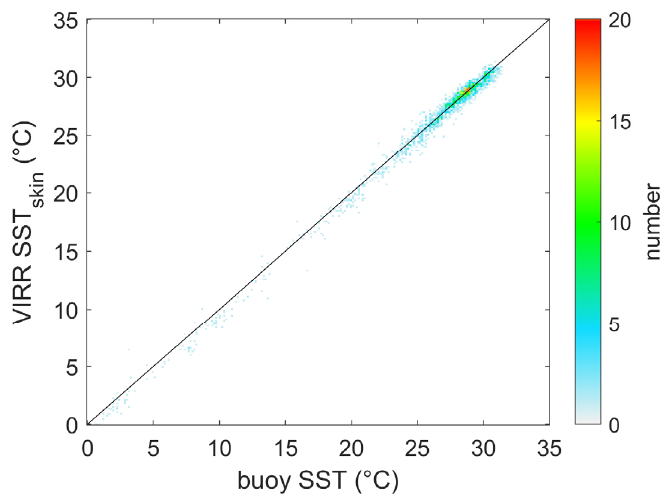
Figure 10. The relationship between the VIRR SST skin and the buoy SST.